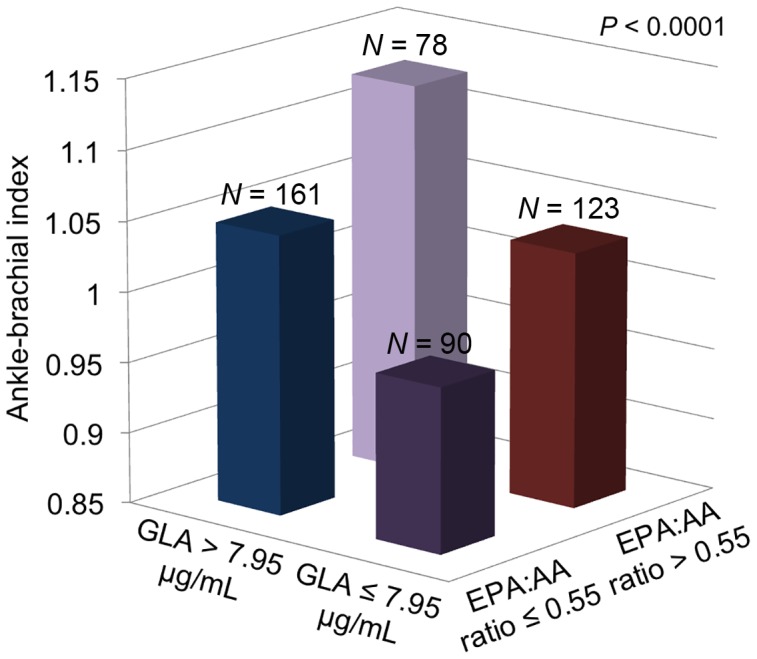
The association of serum levels of gamma-linolenic acid (GLA) and eicosapentaenoic acid∶arachidonic acid (EPA∶AA) ratio with ankle-brachial index levels.Study population was divided into 4 groups by using cut-off values at 7.95 µg/mL of GLA and at 0.55 of EPA∶AA ratio. There was an association of low levels of GLA and low EPA∶AA ratios with the presence of PAD.